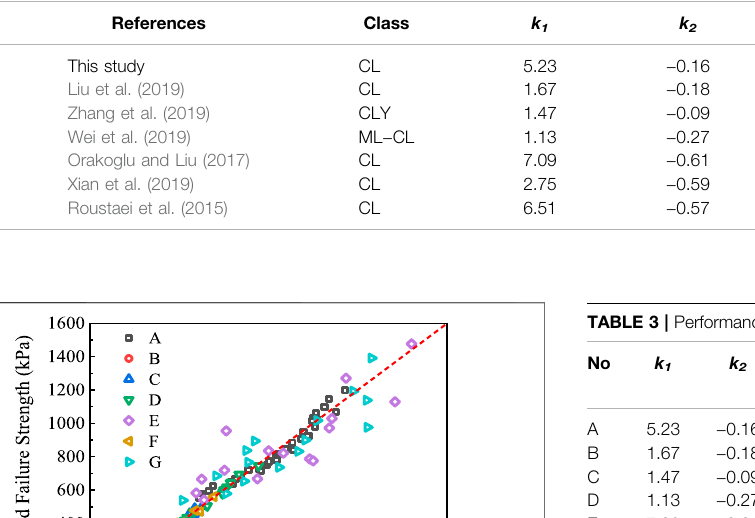
TABLE 2 | Regression coef fi cients in Eq. 3 of different clays.